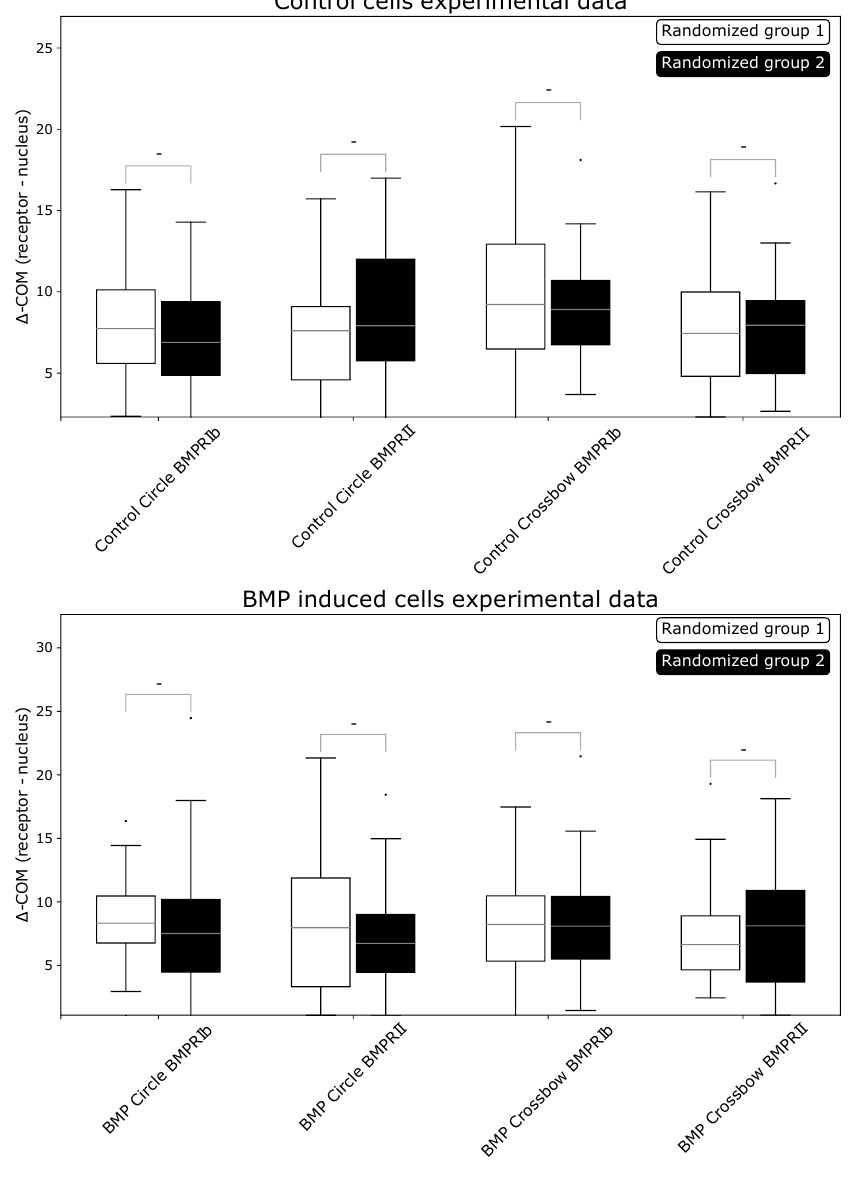
Figure A2. Comparison of experimental data randomly split into two groups for reference metric. Then, ComRed was used to assess differences in distributions. No significant differences were found. - = not